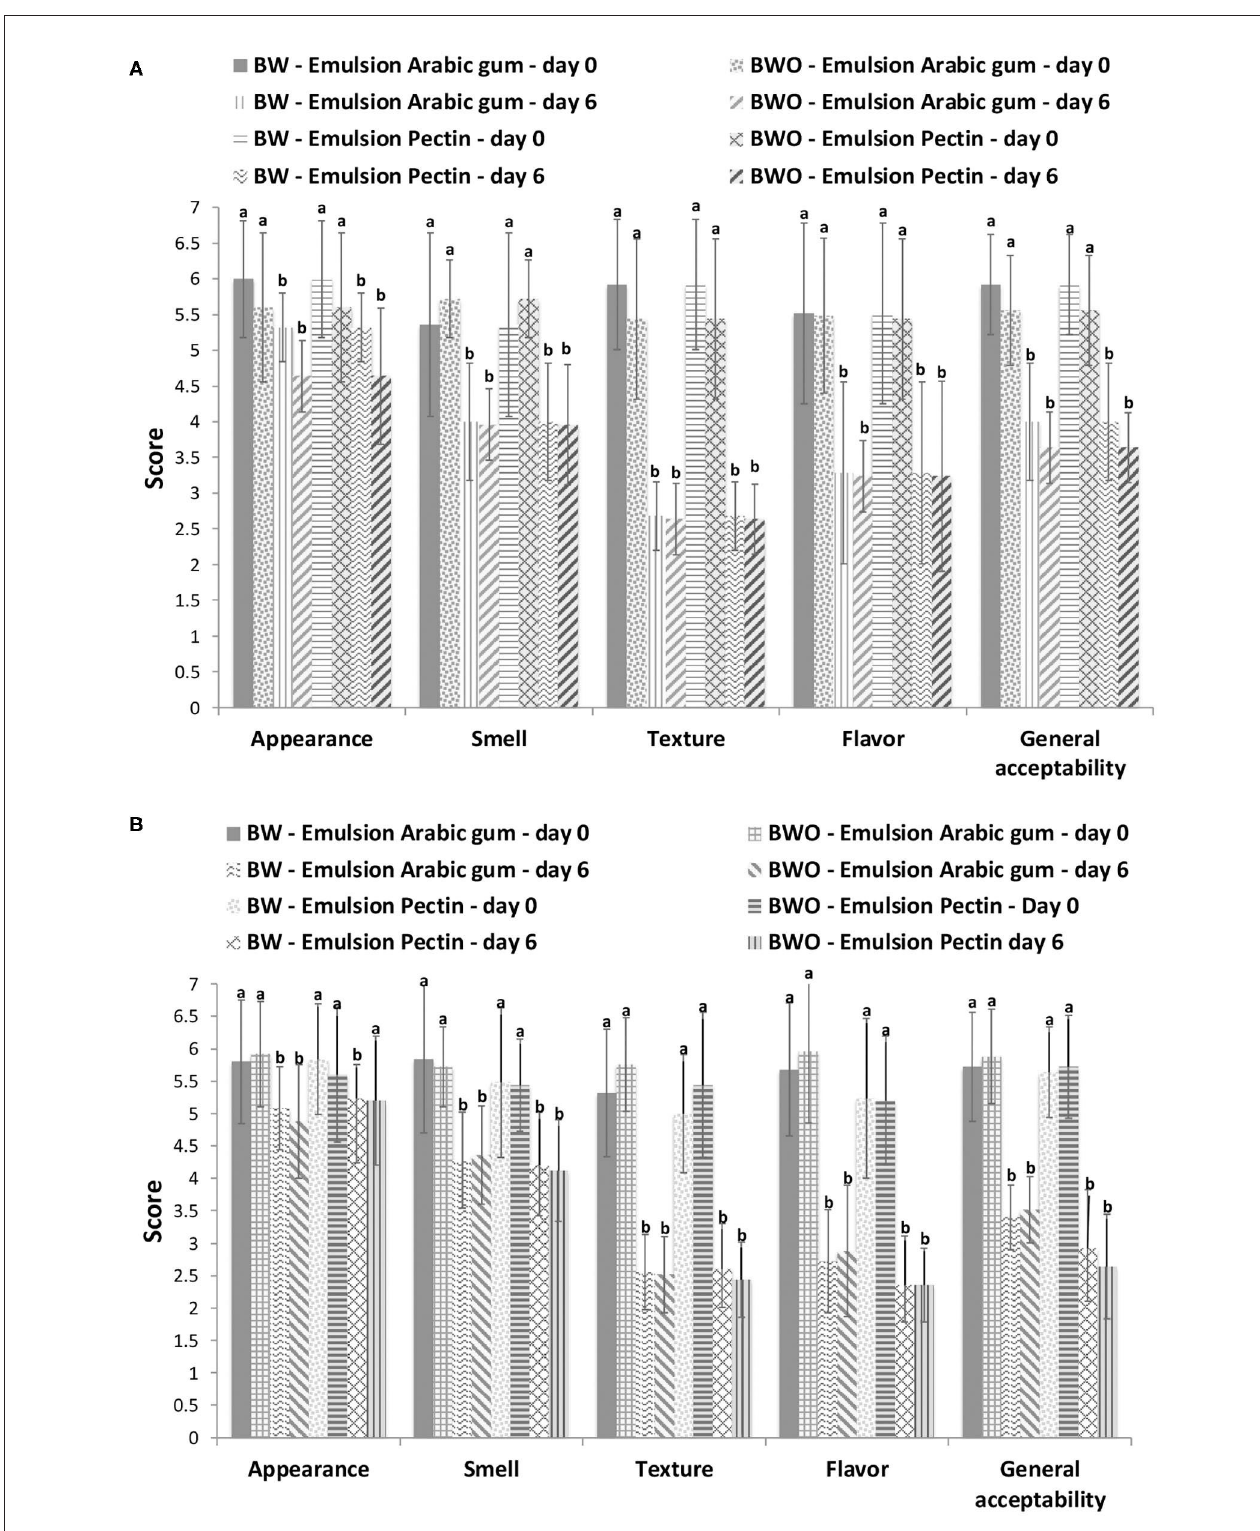
FIGURE 7 | Sensory analysis results of two bagel formulations, bagel-wheat flour (BW) and bagel-wheat flour-oats (BWO), sprayed with emulsions stabilized with pectin or Arabic gum at 10% w/w (A) and 15% w/w (B) of Mexican oregano essential oil (MOEO) evaluated on days 0 and 6. Systems that do not share the same letter for the identical parameter are significantly different ( p <